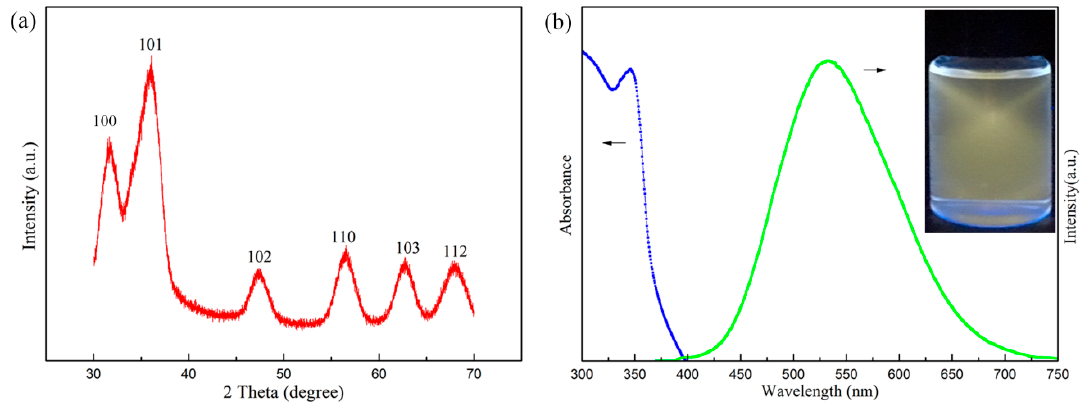
Figure 2. ( a ) XRD pattern of ZnOQD, ( b ) UV-vis and photoluminescence spectra of ZnOQD.